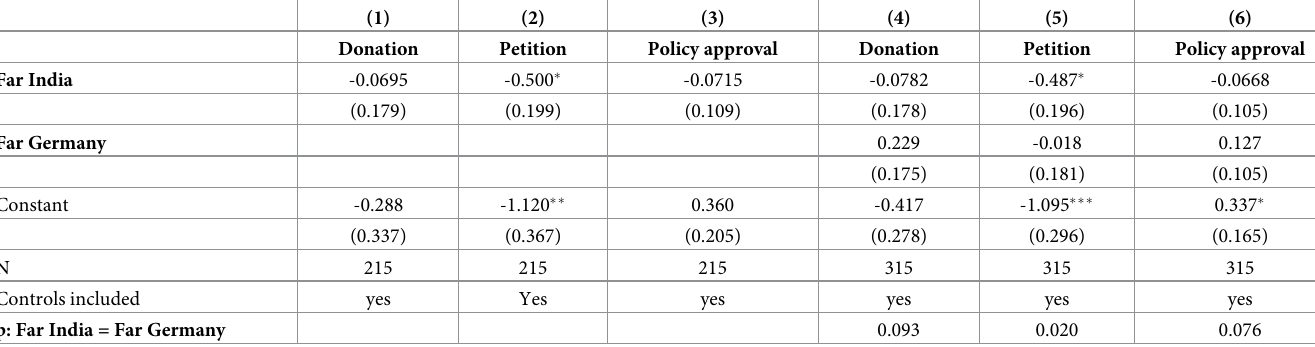
Table 1. Regression results for treatment